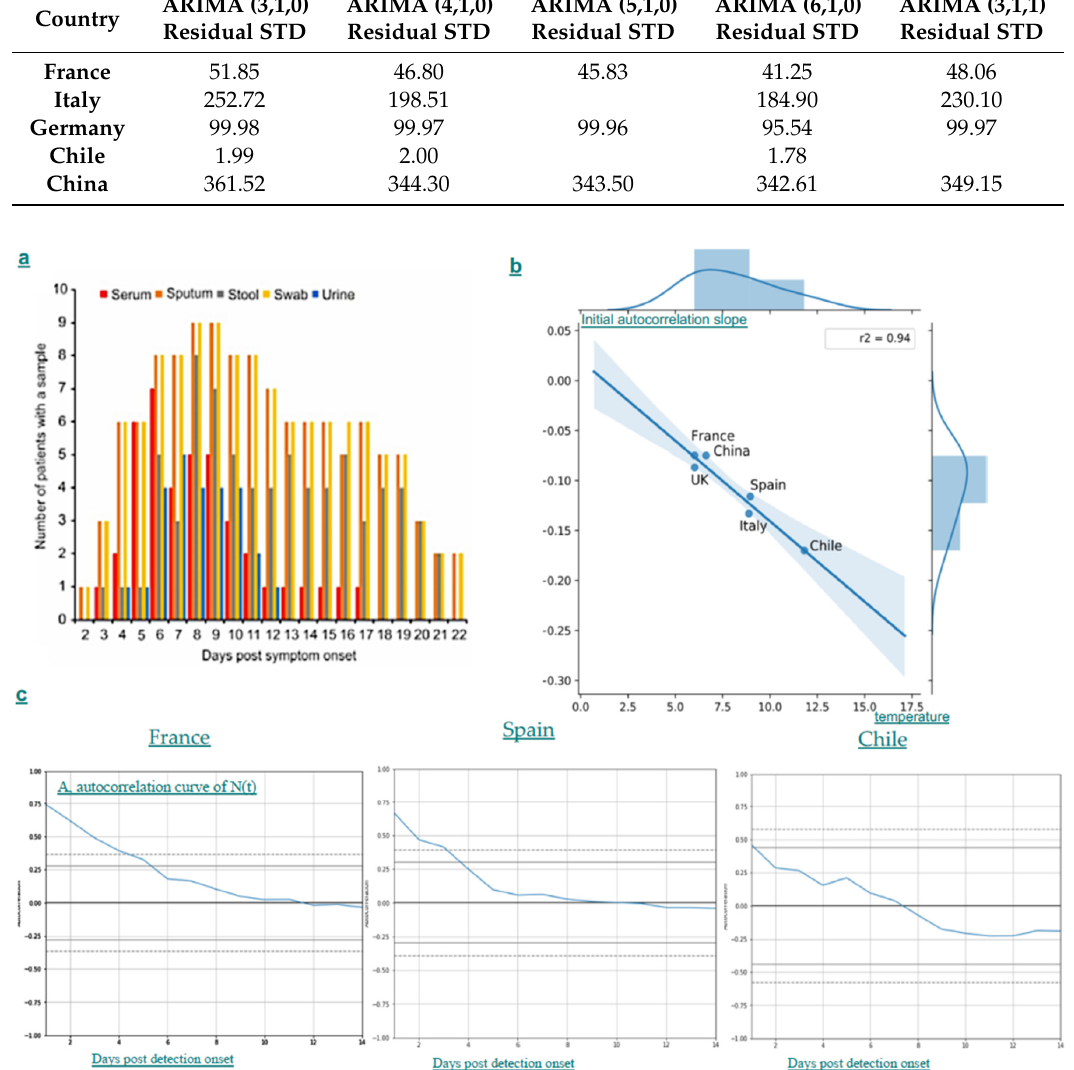
Table 1. ARIMA length of regression of new covid-19 cases on ambient temperature and standard deviation of the residue R(t) for five countries, France, Italy, Germany, Chile and China. (using https: // www.statsmodels.org / stable / generated / statsmodels.tsa.arima_model.ARIMA.html)